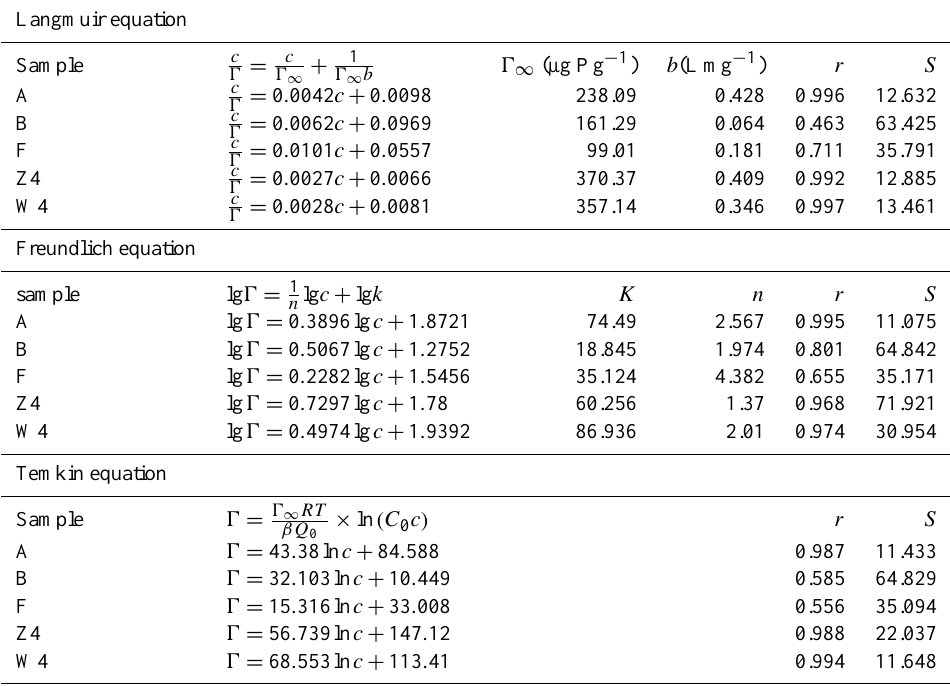
Table 2. Langmuir, Freundlich, Temkin isotherm equations and constants for adsorption of phosphate by different sediments. Langmuir equation